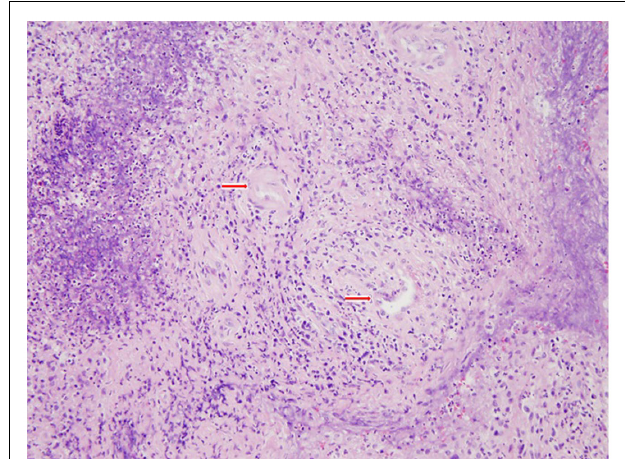
FIGURE 5 | Right nasal pharynx biopsy shows the inflammatory infiltrate surrounding the blood vessels (vasculitis) and showing angioinvasion (H&E stain, 200 × ). Red arrows mark the vessels surrounded by inflammatory infiltrates.